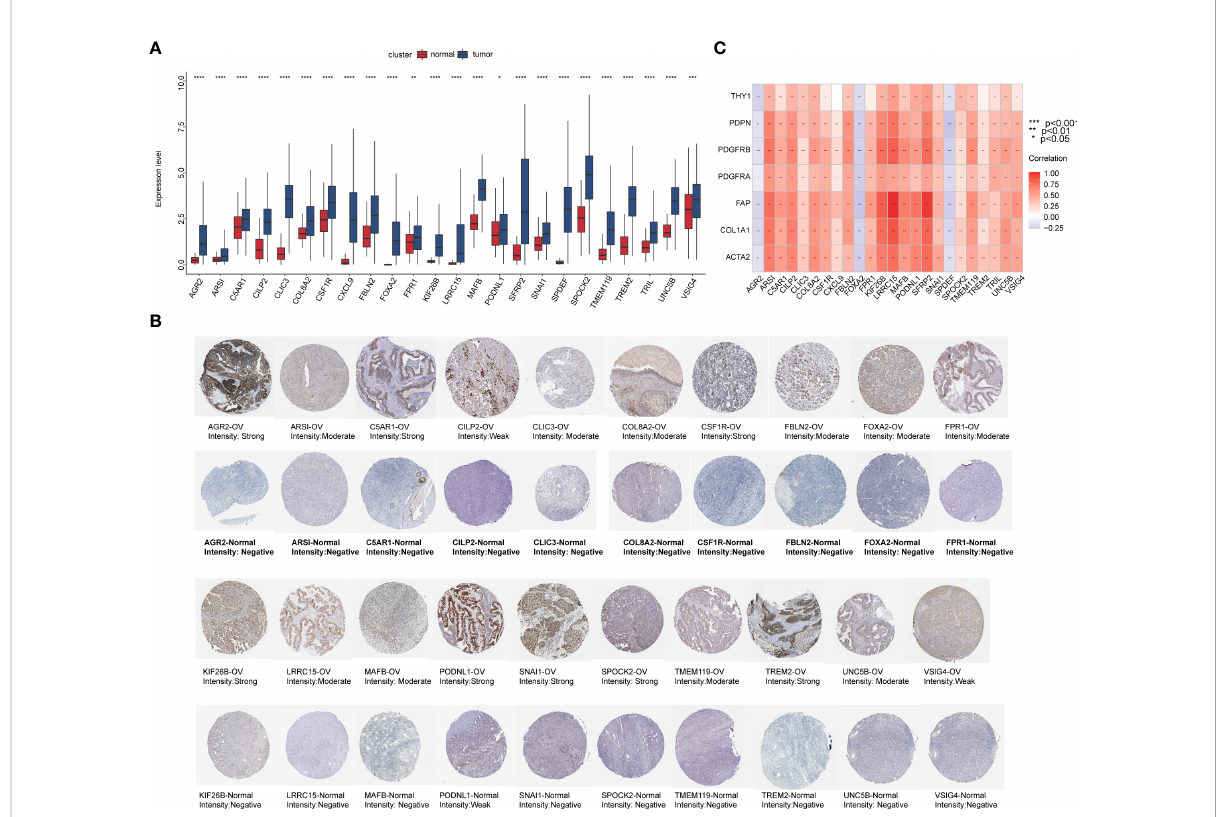
FIGURE 14 The preliminary screened key genes in EOC. (A) The 24 key genes were signi fi cantly upregulated in EOC samples compared to normal ovarian samples (The statistical differences were compared by t-test). (B) Immunohistochemical staining for indicated key genes in EOC tissues and normal ovarian tissues (Human Protein Atlas database). (C) Correlation analysis of 24 key genes with seven CAF